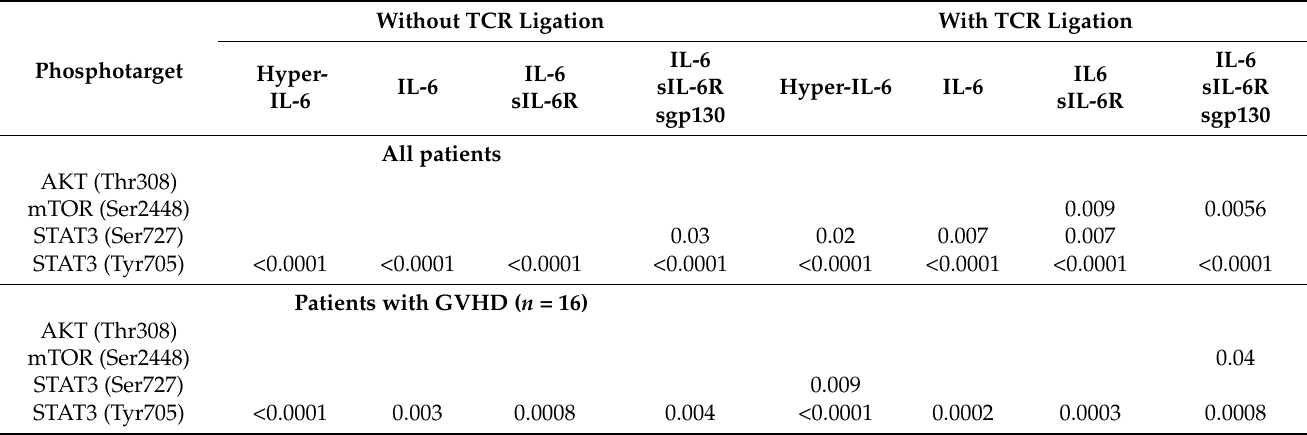
Table 3. The effects of four different forms of IL-6 stimulation on CD3 + CD4 + circulating T cells. The effects on the phosphorylation of the intracellular mediators STAT3/Akt/mTOR were investigated. IL-6 stimulation was tested without and with the activation signal anti-CD3 + anti-CD28. The table presents the statistically significant increases, i.e., p -values < 0.05. The T cells were derived from the peripheral blood of allotransplant recipients with and without previous acute GVHD on day +90 post-transplant. All comparisons were carried out using the Wilcoxon signed-rank